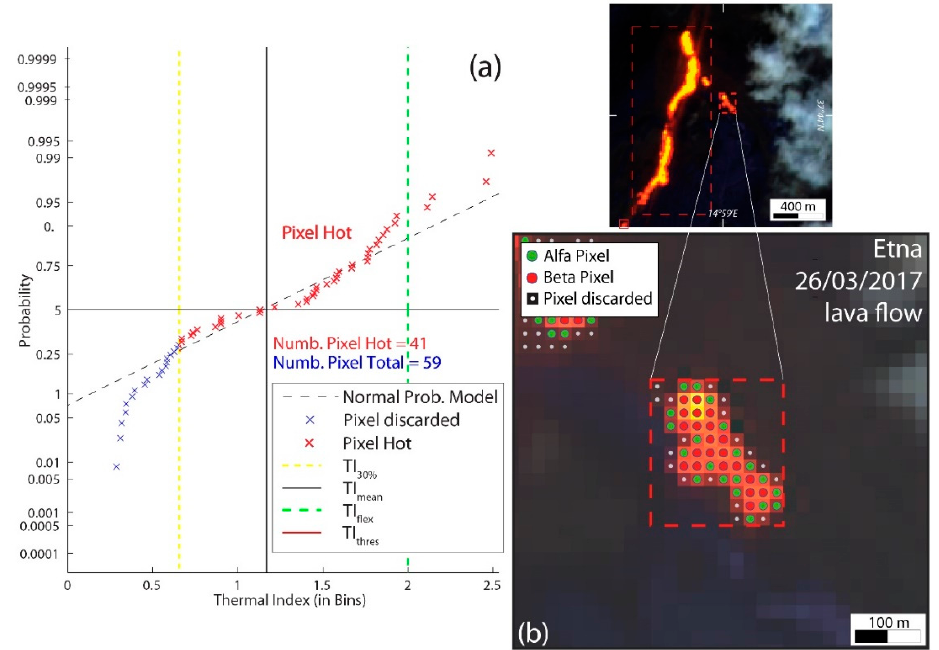
Figure 6. Algorithm application on Etna [61] lava flow small portion, 26/03/2017. ( a ) Normal Probability Distribution plot of the Thermal Index (TI) of the analyzed cluster. In red and blue, hot selected and discarded pixels. Dotted black, solid black, dotted yellow, dotted green and red lines represent, respectively, the theoretical normal distribution model, TI mean , TI flex , TI 30% and TI thres hot threshold, fitting with the TI flex in this case. ( b ) SENTINEL-2 RGB (12-11-8a) image zoomed over cluster analyzed; in green, red and withe, alfa-triggered, beta-triggered and discarded pixels; respectively.